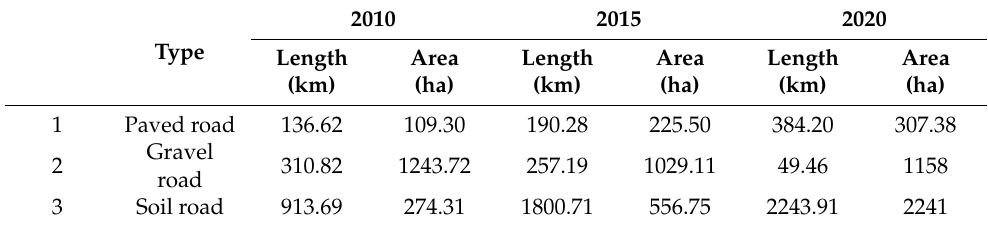
Table 1. Spatial extent of roads within Khanbogd soum during